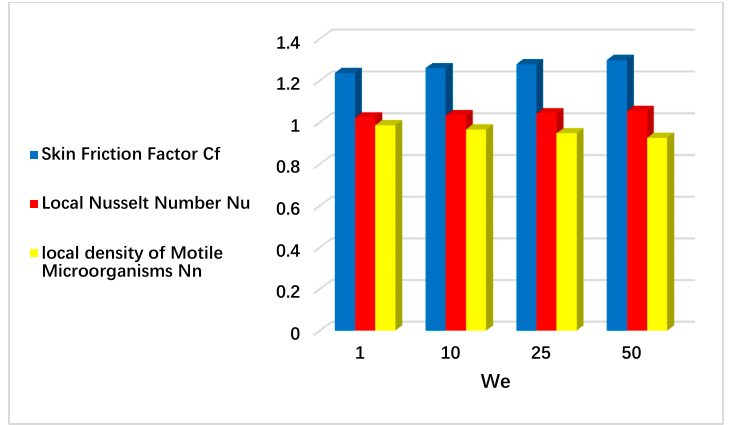
Figure 18. Influence of We against C f , Nu, and Nn